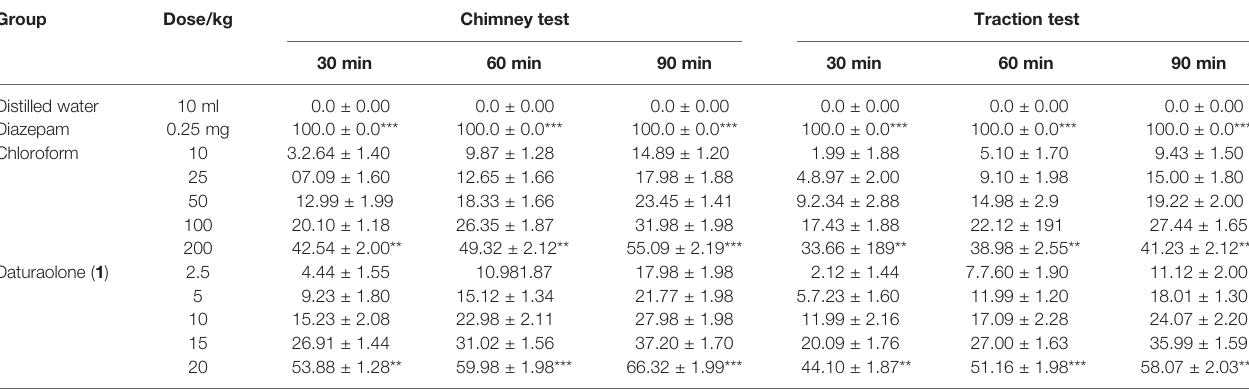
The data of muscle relaxant effect represented the % activity of mice (n = 6) in both models at 30, 60, and 90 min after administration of samples. The data is represented as the mean ± SEM (n = 6); *p < 0.05, **p < 0.0.01, ***p < 0.001, all values as related with